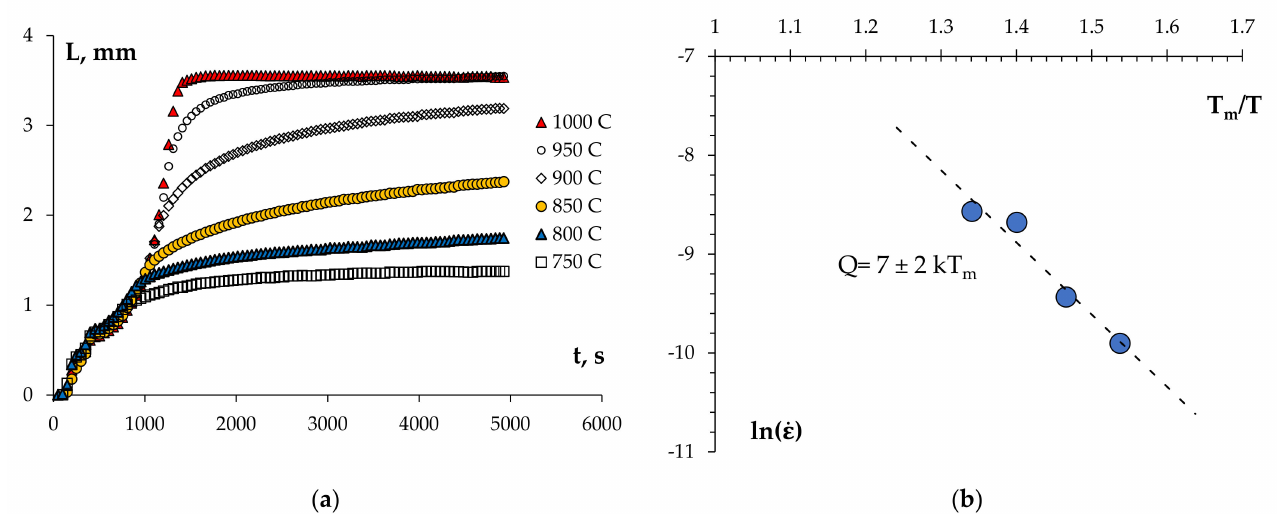
Figure 7. Dependence of shrinkage of submicron α -WC+10 wt.%Co +0.5 wt.%C powder on exposure times at different temperatures ( a ) and dependence of shrinkage rate at isothermal exposure on reciprocal homological temperature of SPS ( b ). In ( b ), T m is the melting point of WC.